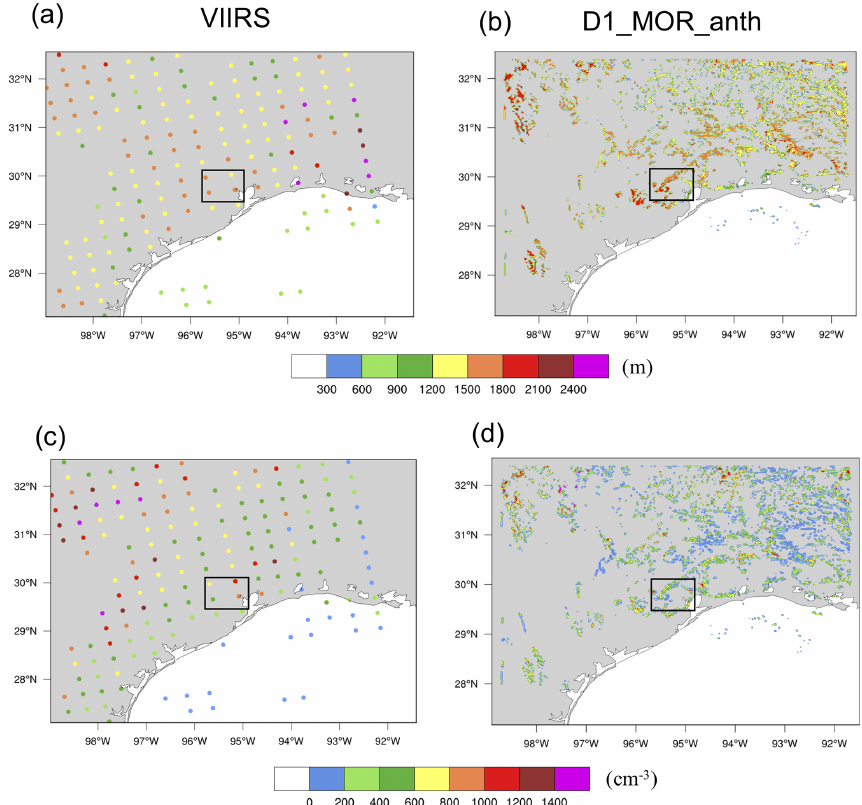
Figure 5. Evaluation of (a, b) cloud base heights (unit: m) and the (c, d) CCN number concentration at cloud base (unit: cm − 3 ) from the VIIRS satellite (a, c) retrieved at 19:43UTC (Rosenfeld et al., 2016) and model simulation D1_MOR_anth (b, d) at 20:00UTC on 19 June 2013. The Houston area is marked using the black box. The satellite-retrieved cloud base height was calculated from the difference between reanalysis surface air temperature (from reanalysis data) and VIIRS-measured cloud base temperature (warmest cloudy pixel) divided by the dry adiabatic lapse rate, whereas modeled cloud base height was determined by the lowest cloud layer with a cloud mass mixing ratio greater than 10 − 5 kgkg − 1